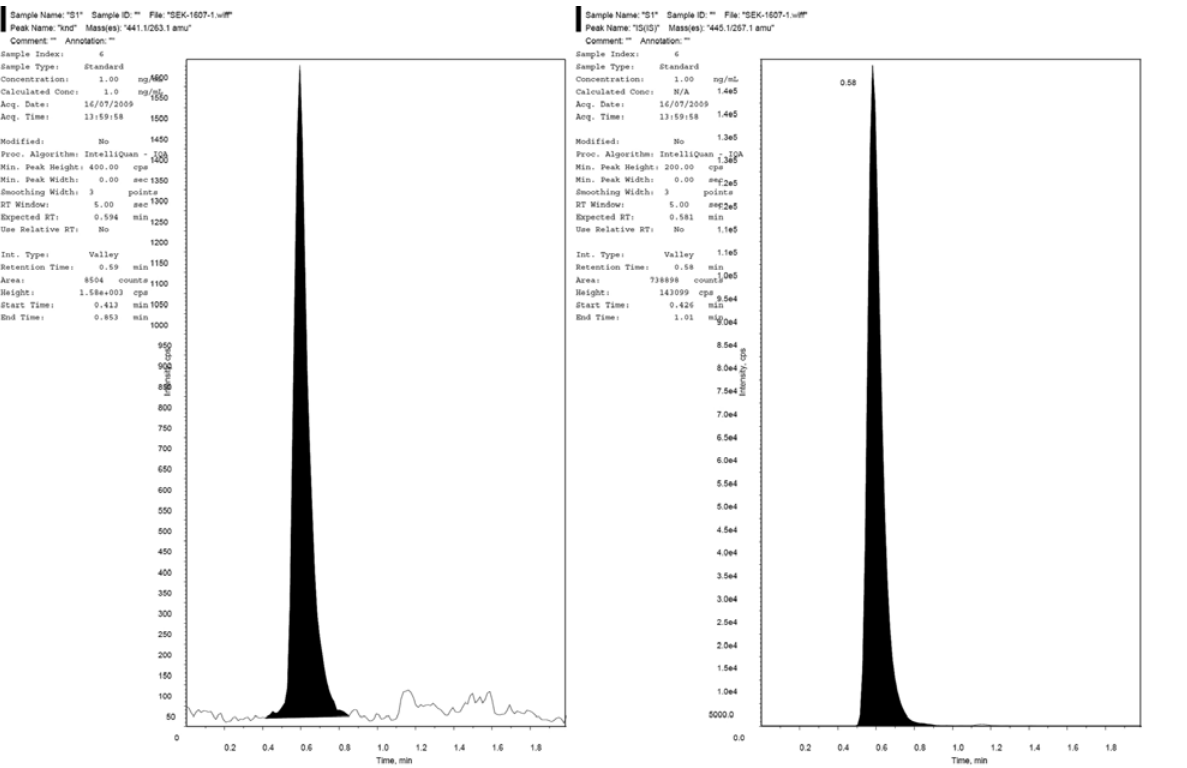
Figure 2: Representative SRM chromatogram of extracted LLOQ plasma sample containing candesartan (1 ng/mL, left) and internal standard (100 ng/mL, right). Table 2: Precision and accuracy of calibration samples and calibration curve parameters of candesartan in human plasma for sample number